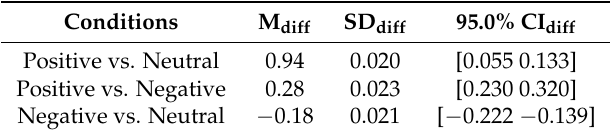
Table A4. Paired two-sample bootstrap test of significance (10,000 simulation runs) at 95.0% confidence interval (CI) applied on the participants’ MSE1 values (i.e., 62 MSE1s associated with 62 EEG channels of a participant, per affect). Compared pairs of mental states are: positive versus neutral, positive versus negative, and negative versus neutral. M: mean difference, SD: standard deviation of such a difference. CI: 95% confidence interval for every paired affective states’ difference.